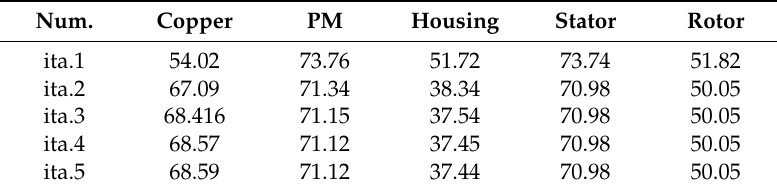
Figure 14. Temperature distribution obtained the steady state TH coupling model. Table 2. EM Losses Obtained by the Steady State Analysis (W).